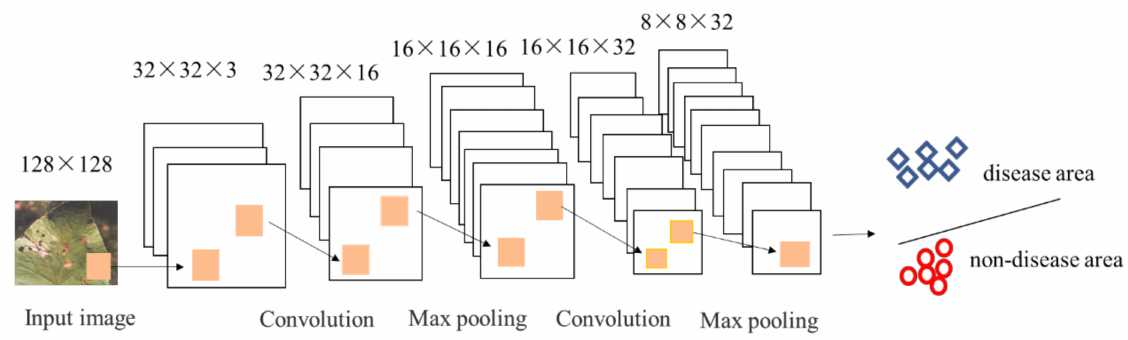
Figure 5. The network structure of disease area